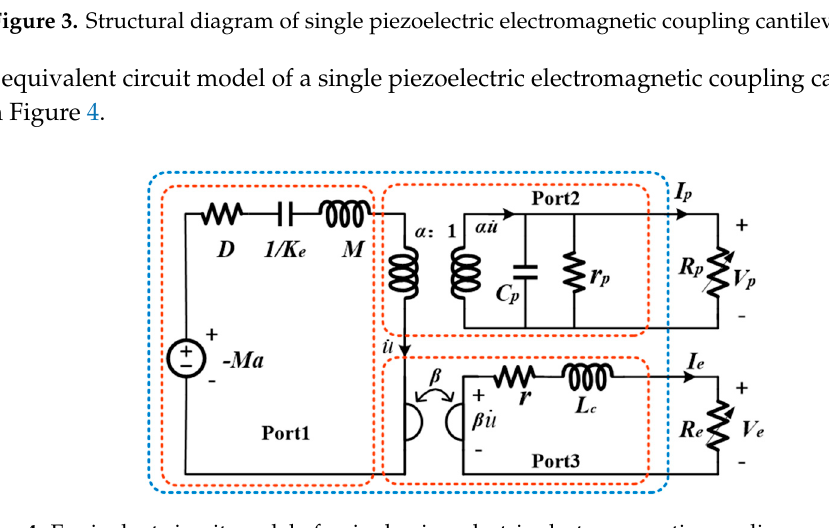
Figure 4. Equivalent circuit model of a single piezoelectric electromagnetic coupling cantilever beam. Port1: mechanical domain, Port2: piezoelectric unit, Port3: electromagnetic unit.